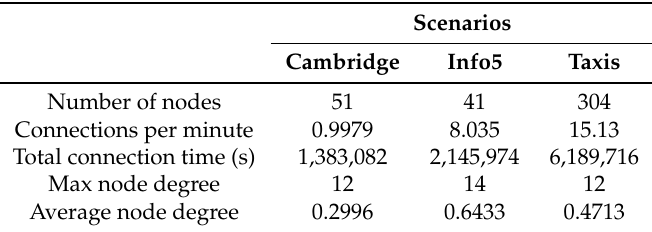
Table 1. Characteristics of 3